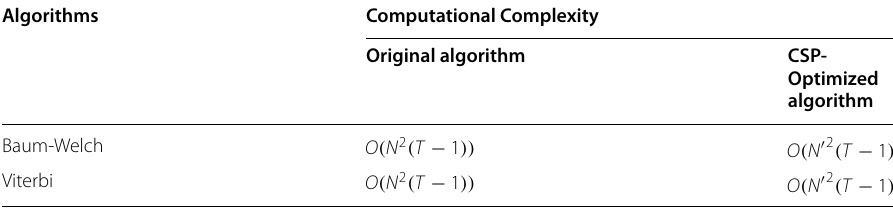
Table 3 Computational complexity comparison Algorithms